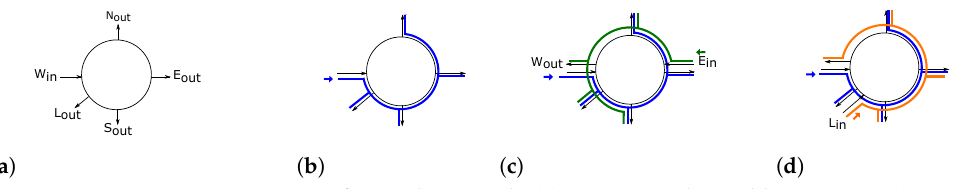
Figure 4. R-NoC router generation for mesh network. ( a ) West in. and possible out. ports. ( b ) Out. ports for west in. port. ( c ) Out. ports for west and east in. ports. ( d ) Out. ports for west and local